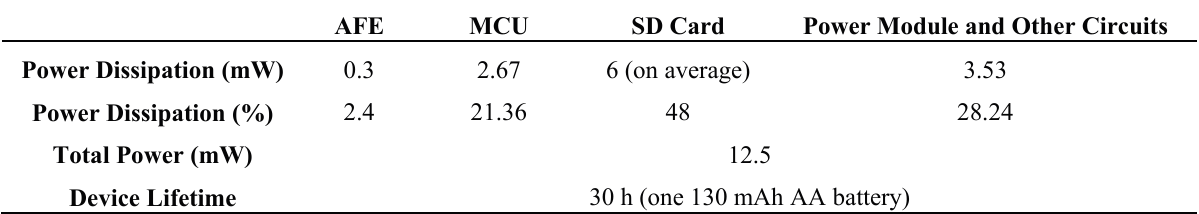
Table 2. Power consumption of the proposed ECG acquisition device.